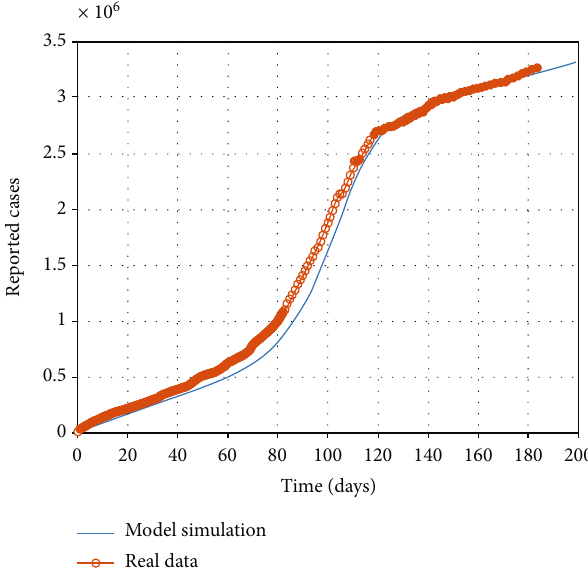
Figure 1: Simulated data vs. Real data for the SARS-CoV-2 cases in Turkey from 01 January 2021 to 03 July